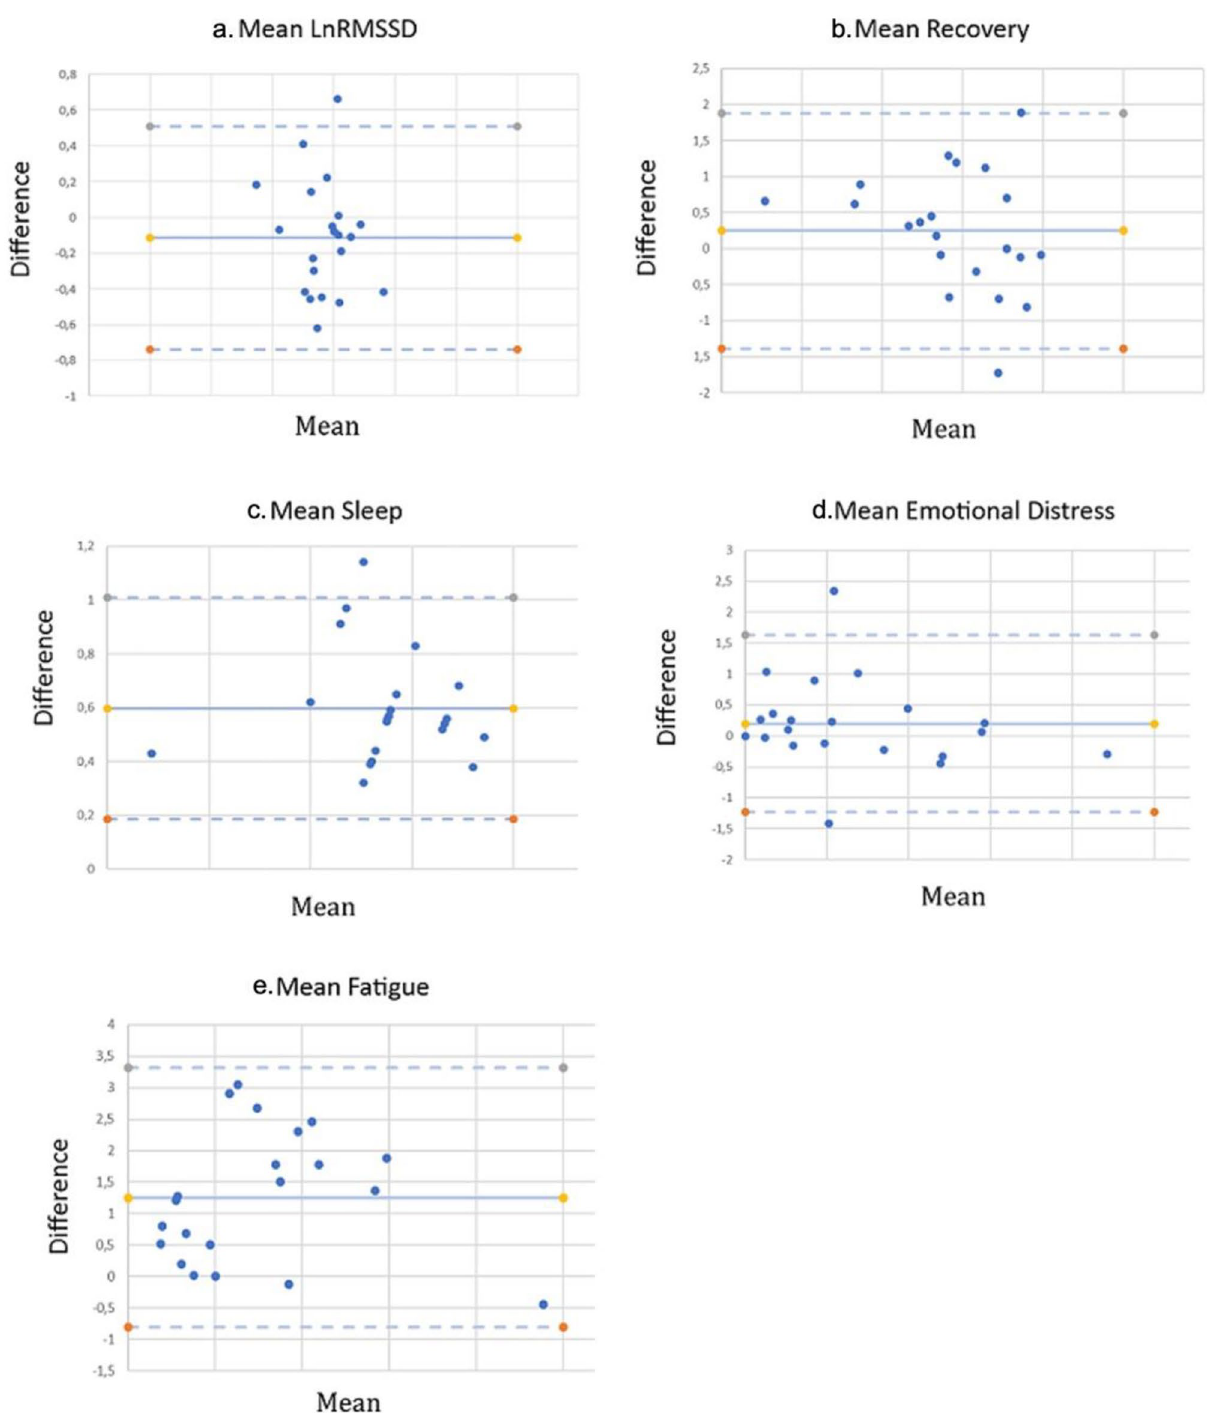
Figure 2. ( a – e ) Bland-Altman scatterplots created in order to assess agreement between ATOPE+ methods and Gold Standard methods for HRV parameters, recovery, sleep, emotional distress and fatigue of